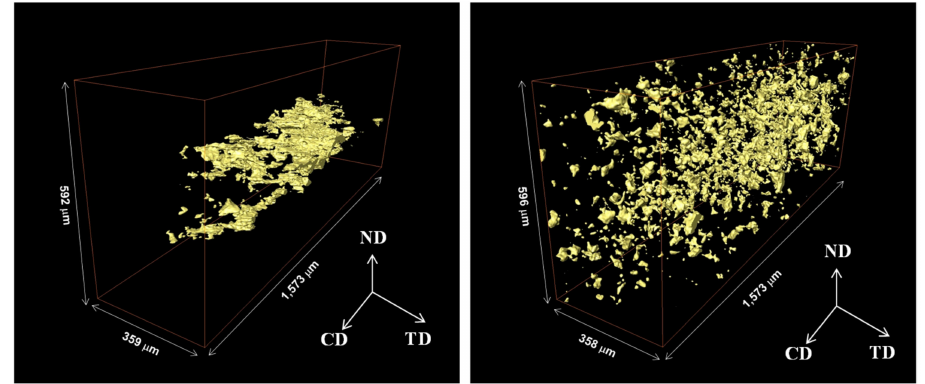
Figure 5. 3D images of center segregation in the strips fabricated at ( a ) 3 m / min, and ( b ) 5 m /